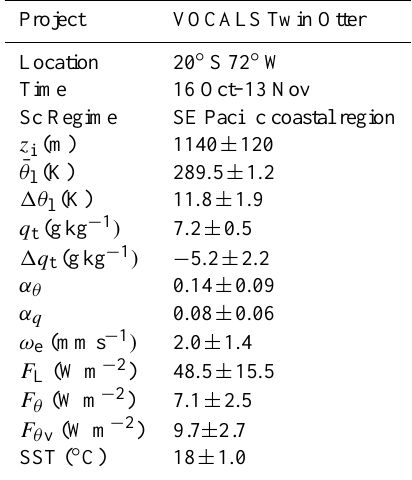
Table 2. Mean values of boundary layer from VOCALS Twin